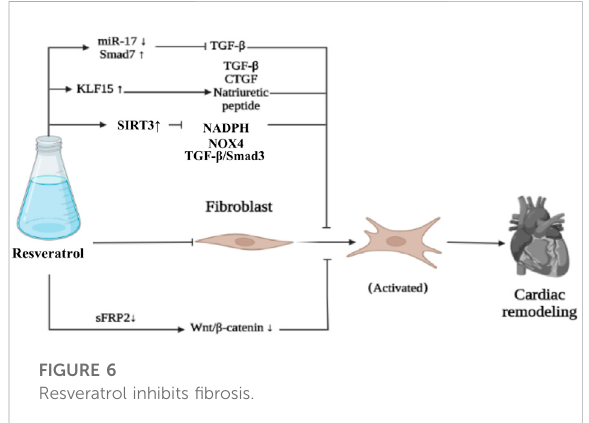
FIGURE 6 Resveratrol inhibits fi